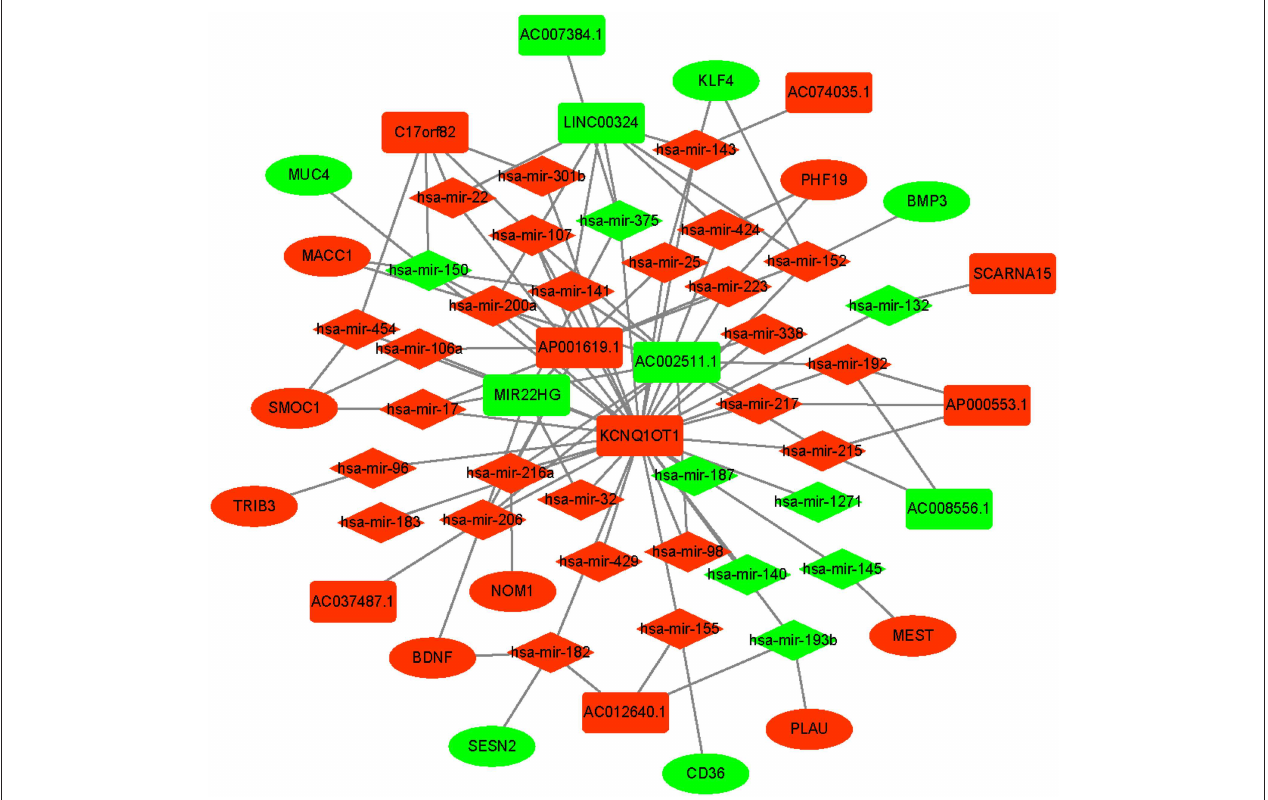
FIGURE 8 | Prognostic competing endogenous RNA (ceRNA) network in colon cancer. The red indicates of the strongly expressed RNAs, and the green indicates the weakly expressed RNAs. The square represents lncRNAs, the diamond represents miRNAs, and the ellipse represents mRNAs.